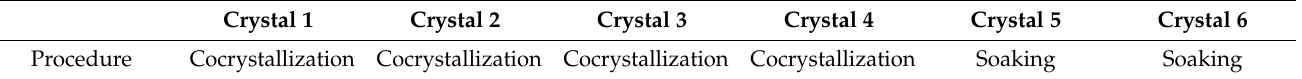
Table 1. Data collection and refinement